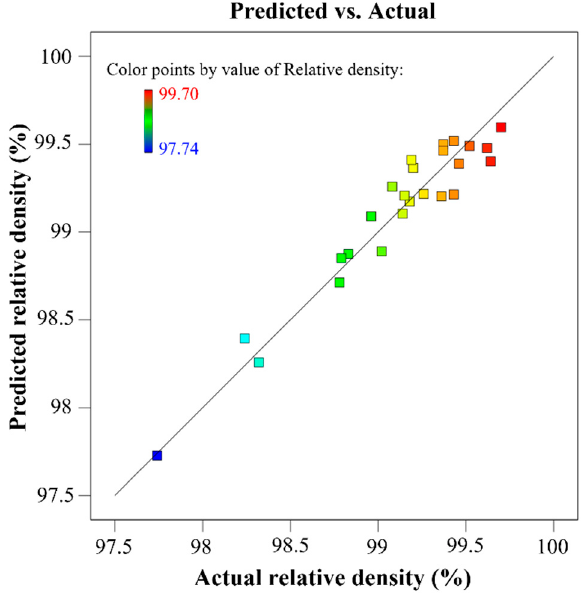
Figure 10. Correlation graph of the experimental values and predicted values of relative density.